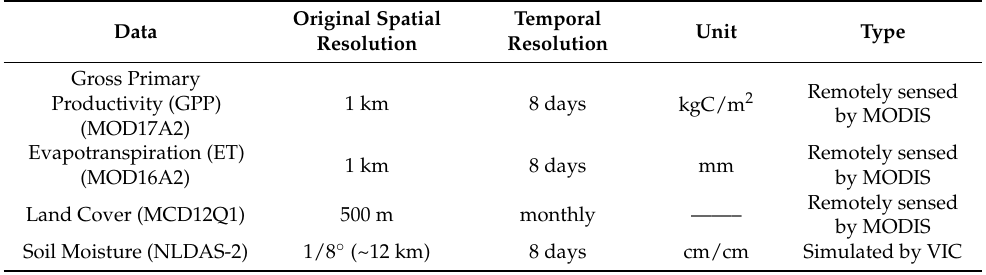
Table 1. Summary of the data used in this study and their